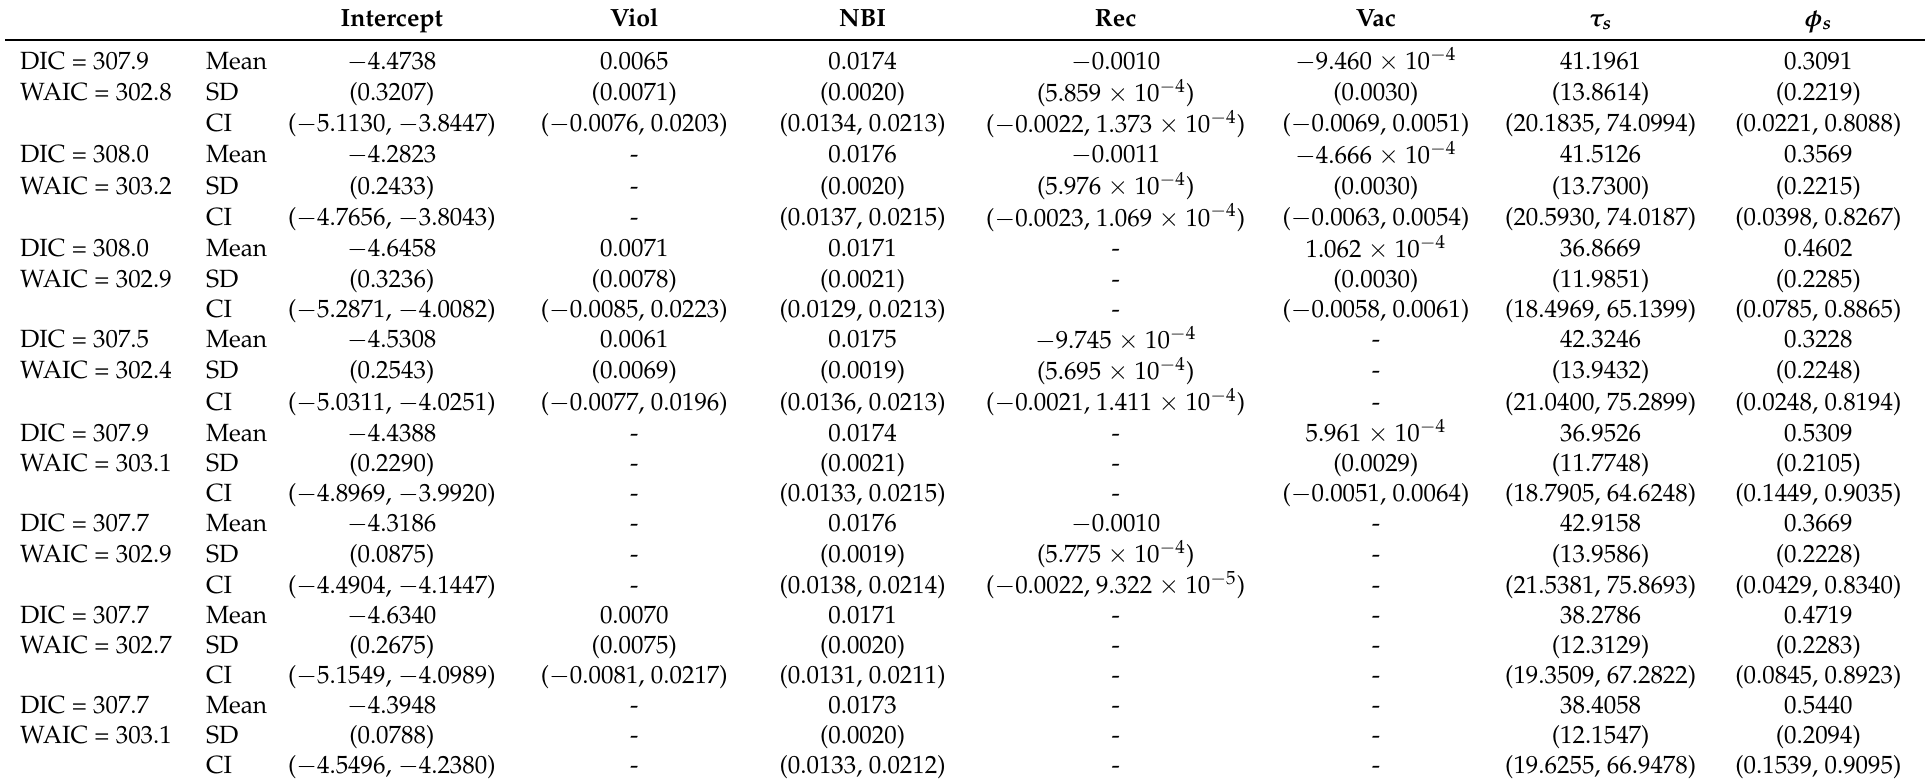
Table 11. Parameter estimates, standard deviations and 95% credible intervals for the estimated means in parenthesis, DIC and WAIC values for the reduced versions of the BYM2 model fitted in INLA to the Colombian infant mortality rates data